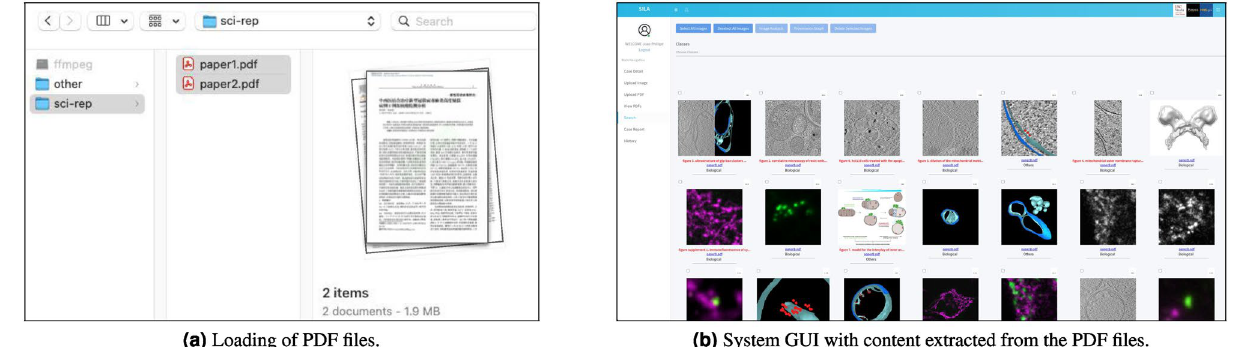
Figure 3. Examples of the implemented system GUI components. In ( a ), the operating-system agnostic interface allows the analyst to upload multiple scientific papers of interest as PDF files. In ( b ), the web browser- based system GUI is already populated with content automatically extracted by the system from the provided PDF files. The interface follows the standard of web pages, letting the analyst perform each one of the five tasks represented in Fig. 2b. In this example, for illustration’s sake, the depicted content was extracted with SILA from the publication available through the DOI https:// doi. org/ 10. 7554/ eLife. 40712, under the Creative Commons public domain